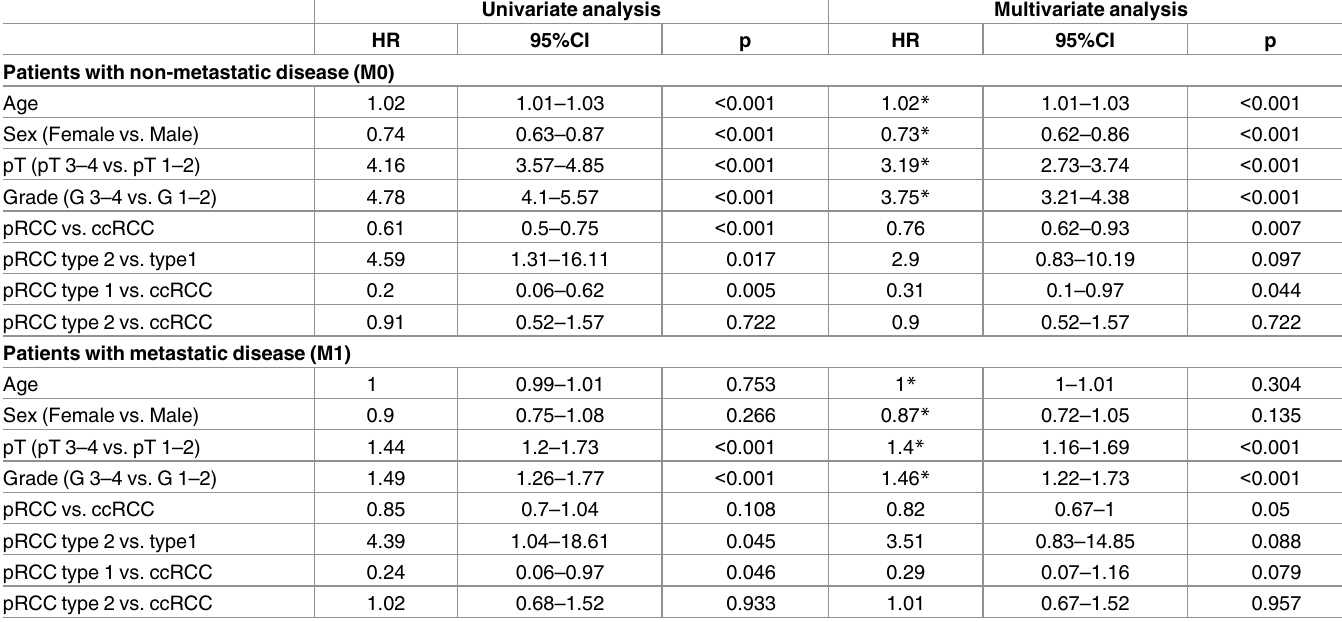
Table 3. Uni- and multivariate Cox cause-specific hazardsanalysisof pRCC, ccRCC,and pRCC subtypes(type 1 and type 2) and clinical/ patholog- ical variables for the prediction of cancer-specific mortality in patients with non-metastatic and metastatic RCC. Univariate analysis Multivariate analysis HR